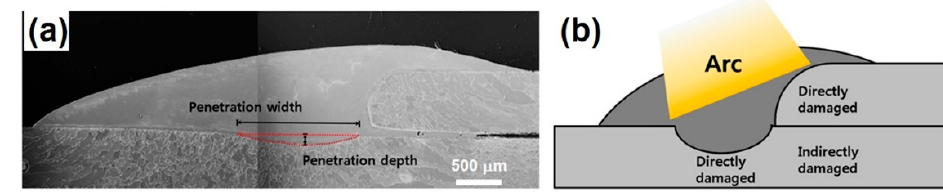
Figure 6. ( a ) Measurement of penetration width and depth, ( b ) Schematic showing damaged zones.